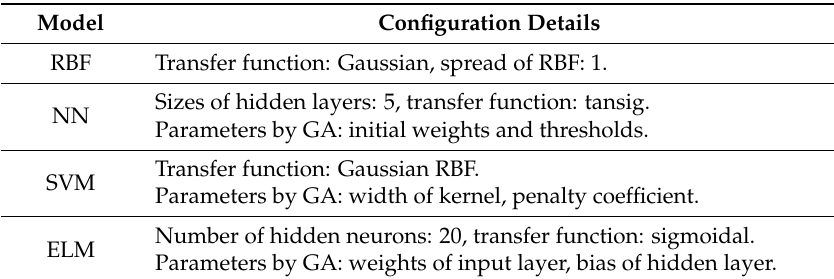
Table 3. Main configuration details of each model. RBF: radial basis function; NN: neural networks;